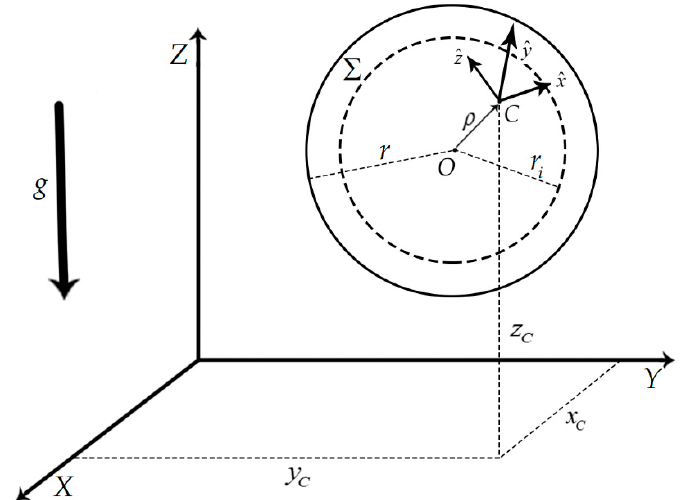
Figure 1. The unconstrained system consisting of the non-uniform spherical shell, Σ , with center of mass at C and geometric center at O , under the force of gravity.